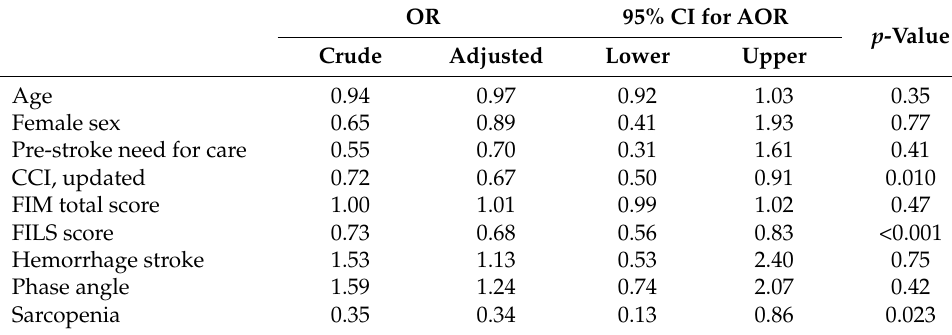
Table 3. Logistic regression analysis for FILS gain ( ≥ 2 points).